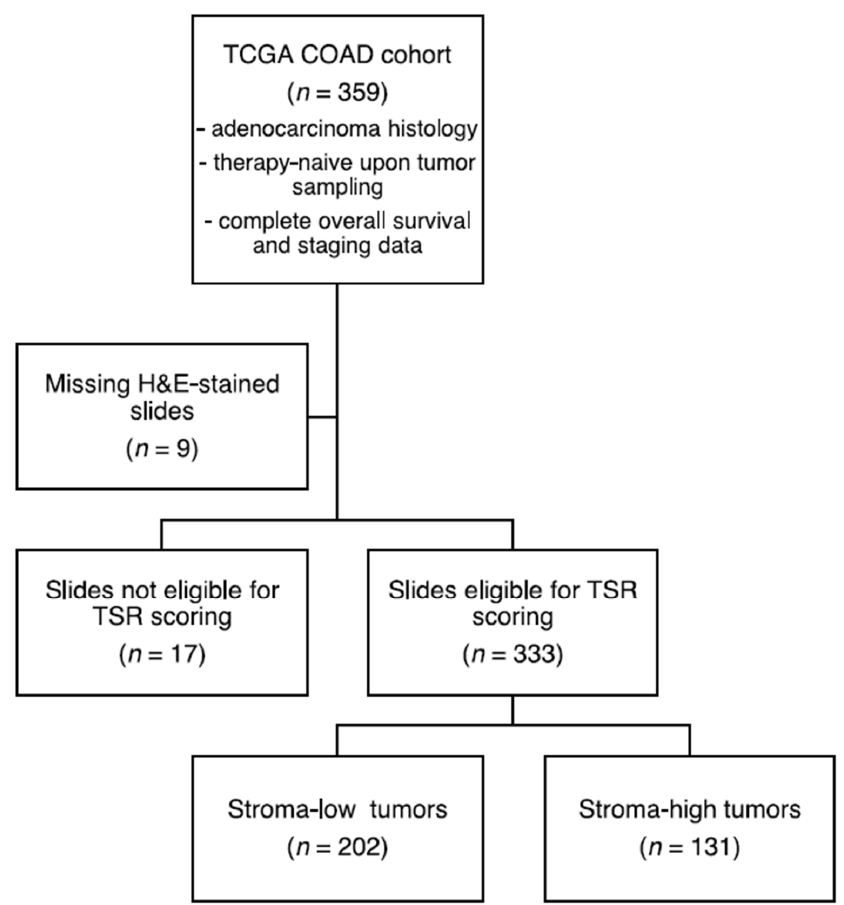
Figure 2. Flowchart of histologic tumor-stroma ratio (TSR) scoring. H&E, hematoxylin & eosin.